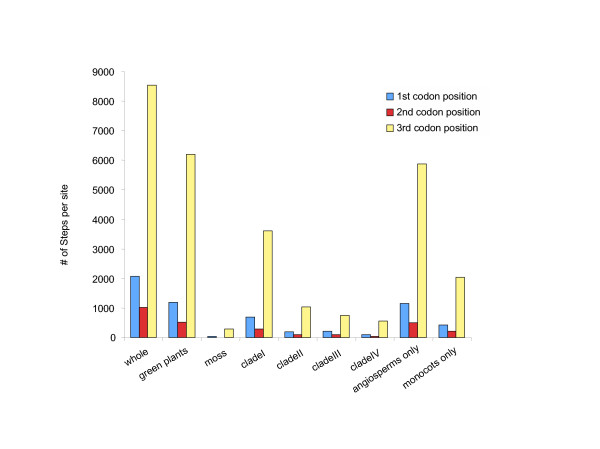
Mean number of inferred nucleotide substitutions by codon position based on the comparison of 139 GSK homologs. Subsets of the full data set are based on the results of the phylogenetic analysis of GSKs (green plants, moss, clade I, clade II, clade III, clade IV) or represent well-recognized organismal groups (angiosperms, monocots).